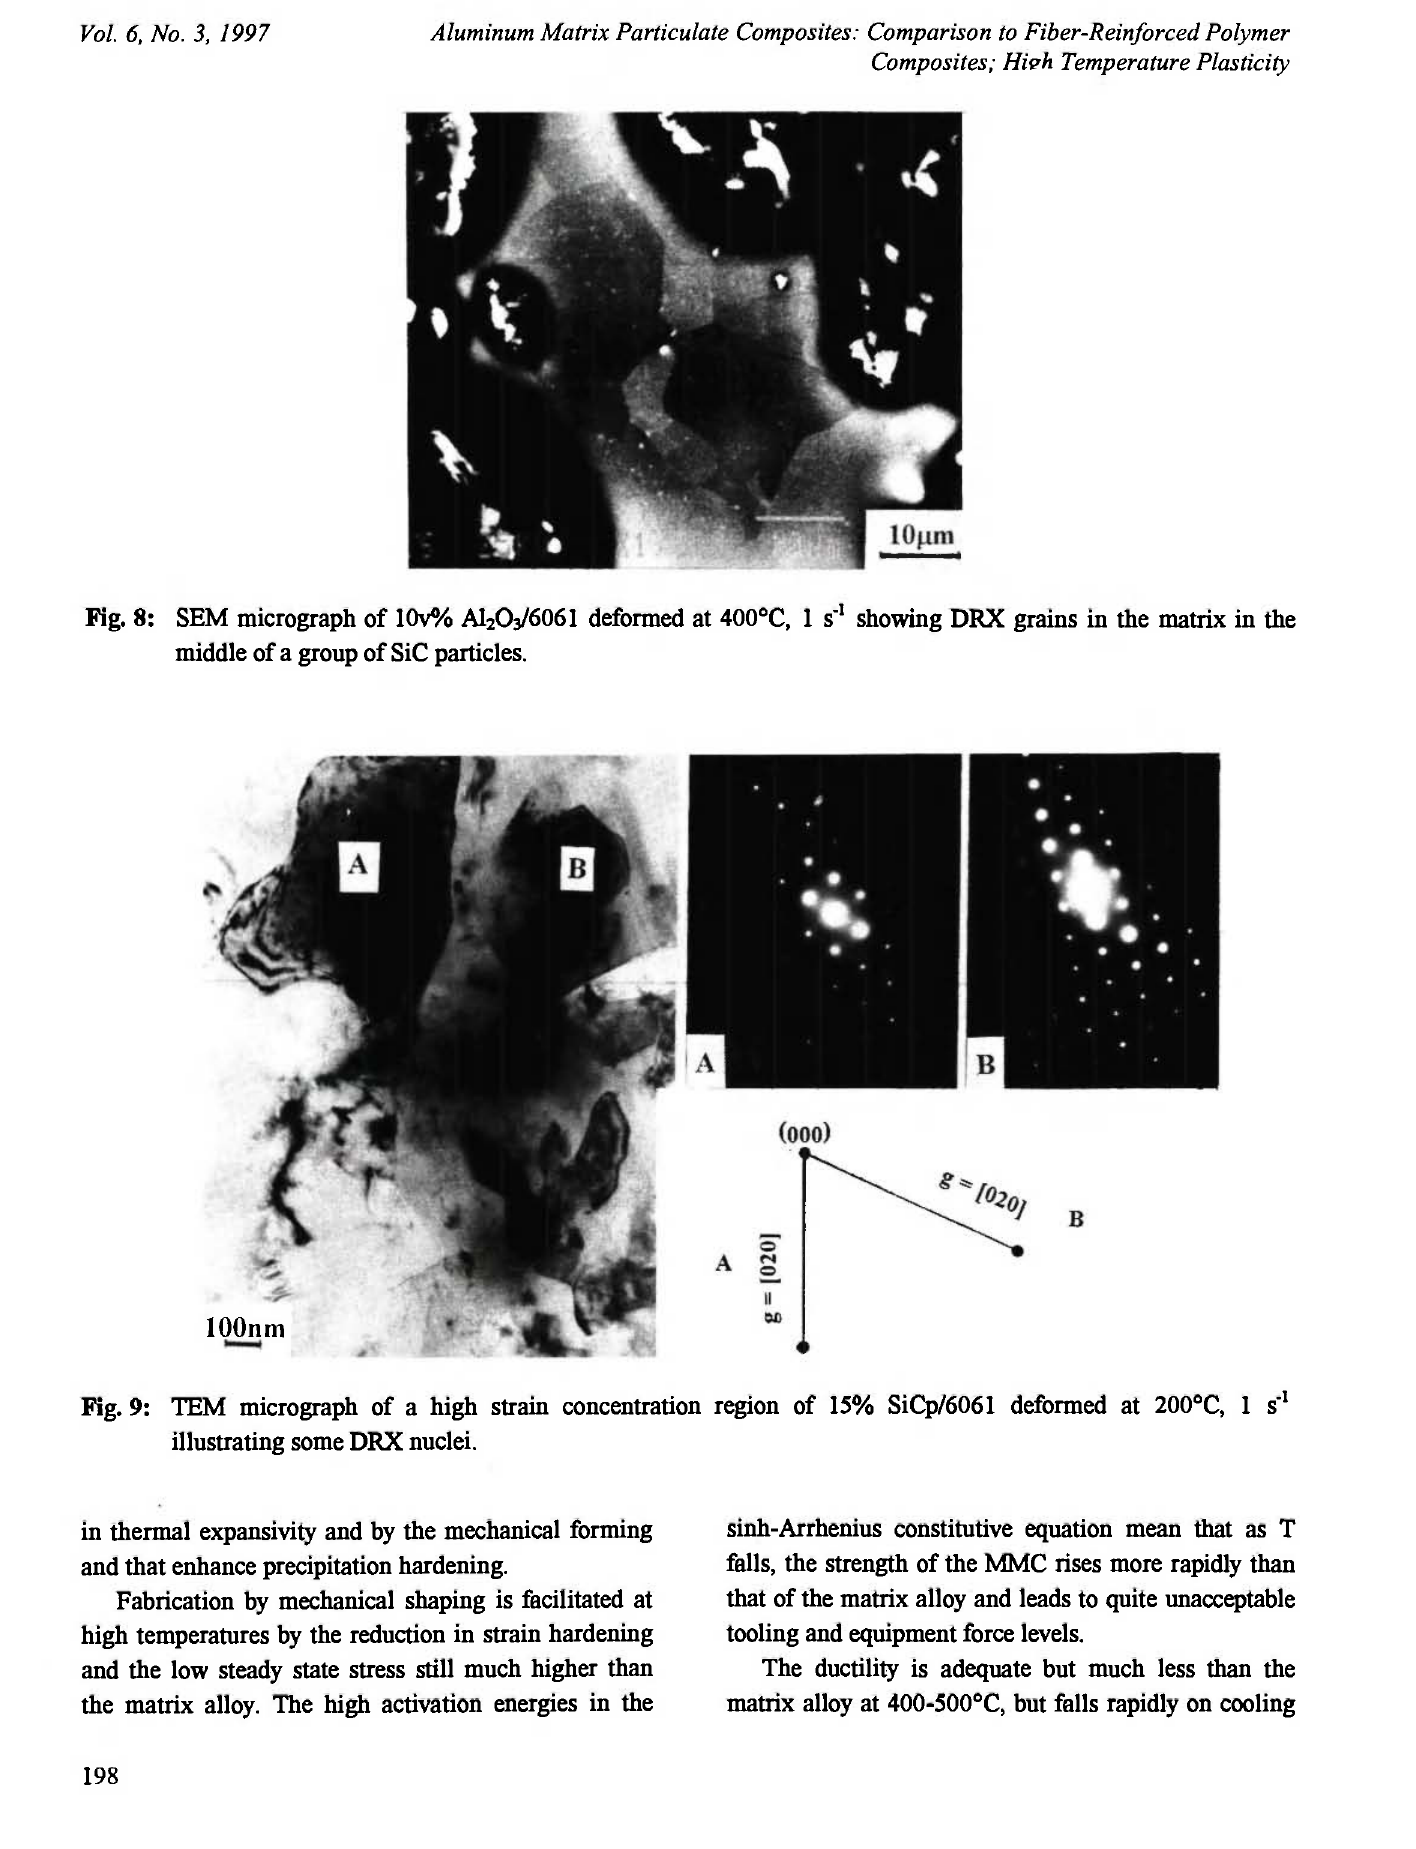
Fig. 9: TEM micrograph of a high strain concentration region of 15% SiCp/6061 deformed at 200°C, 1 s" 1 illustrating some DRX